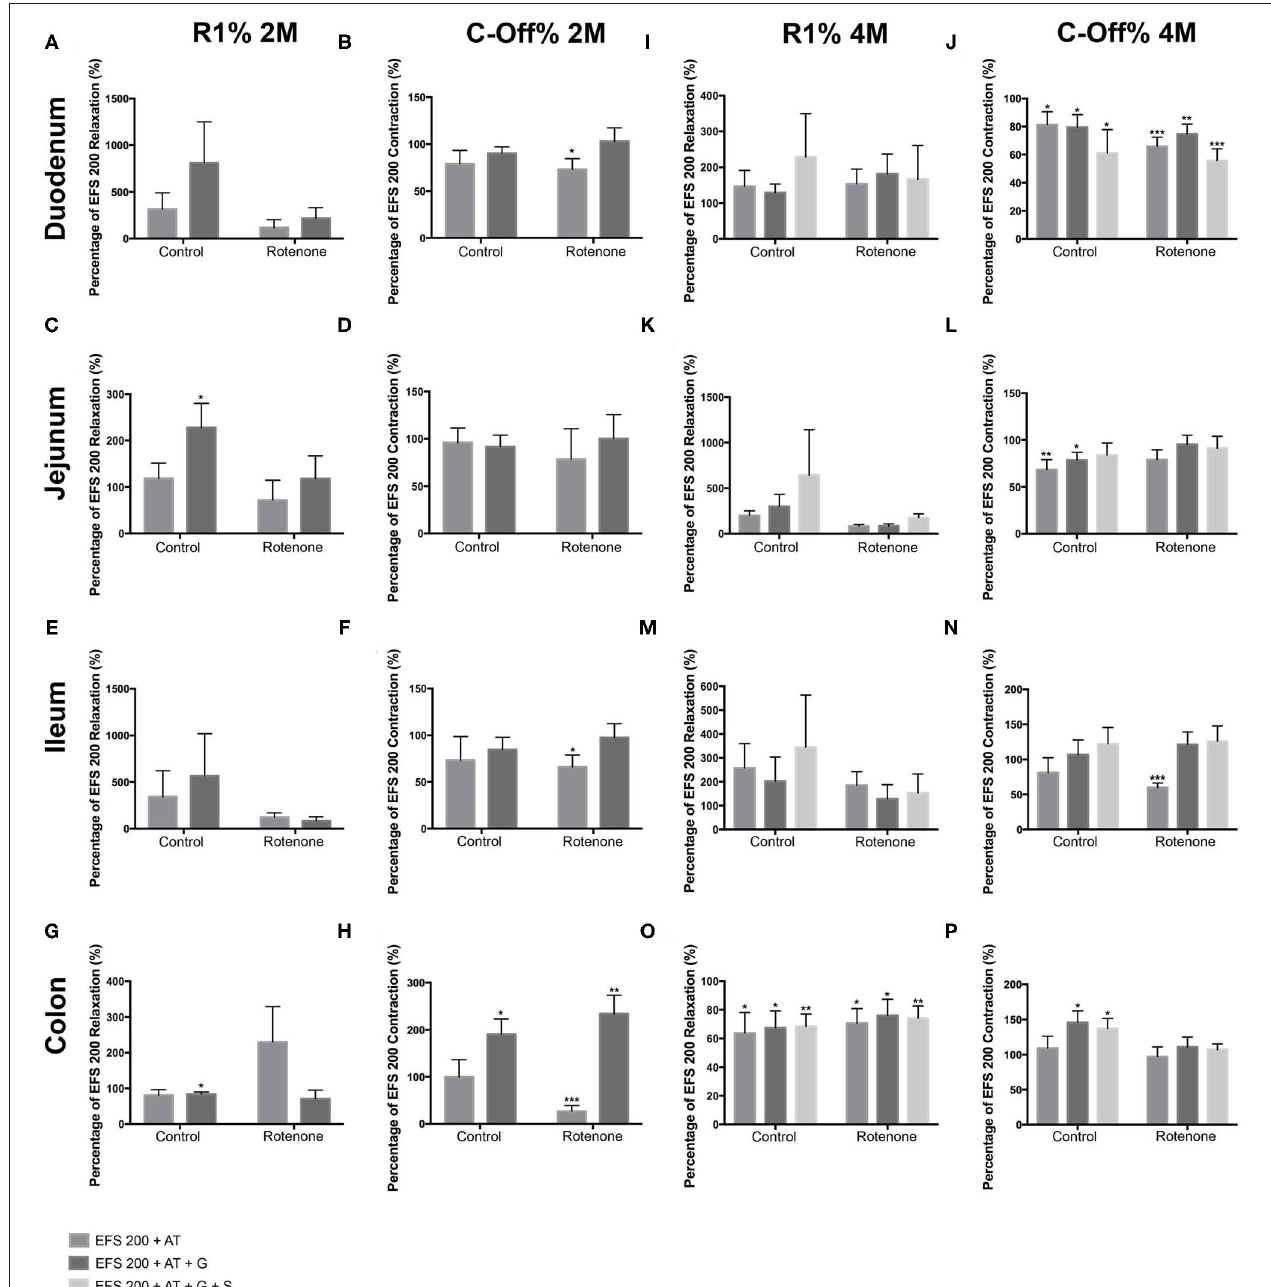
FIGURE 6 | Effect of a 200 µ s electric field stimulation (EFS 200) on the different intestinal regions after 2 and 4 months of rotenone exposure in mice. In all regions, AT induced a deeper relaxation and a lower contraction when compared to the reaction observed without atropine (AT) or guanethidine (G) when EFS 200 and EFS 400 were applied. Data in figures is shown as a percentage of the EFS 200 or EFS 400 relaxation/contraction obtained without neurotransmitters and the p -values refer to this percentage, if an additional significant difference between control and exposed samples is shown, the p -value will be written separately. (A–H) Graphics showing the R1 and the C-Off induced by EFS 200 on the duodenum (A,B) , jejunum (C,D) , ileum (E,F) , and colon (G,H) in Krebs solution alone, in the presence of atropine or in the presence of atropine and guanethidine after 2 months of rotenone exposure. (I–P) Graphics showing the R1 and the C-Off induced by EFS 200 on the duodenum (I,J) , jejunum (K,L) , ileum (M,N) , and colon (O,P) in Krebs solution alone, in the presence of atropine or in the presence of atropine and guanethidine after 4 months of rotenone exposure. Data was analyzed using a 2-way ANOVA Values of the effect of exposure are shown under the corresponding graph. *, **, *** correspond to P < 0.05, P < 0.01, and P < 0.001, respectively. Error bars represent SEM in all graphics. Data was analyzed using a Student’s t -test, *, **, *** correspond to P < 0.05, P < 0.01, and P < 0.001, respectively. Error bars represent SEM in all